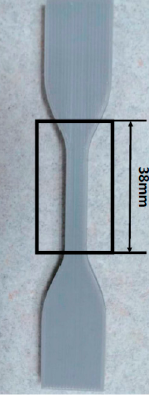
Figure 2. Schematic illustration of a cone-beam X-ray computed tomography (XCT) system.